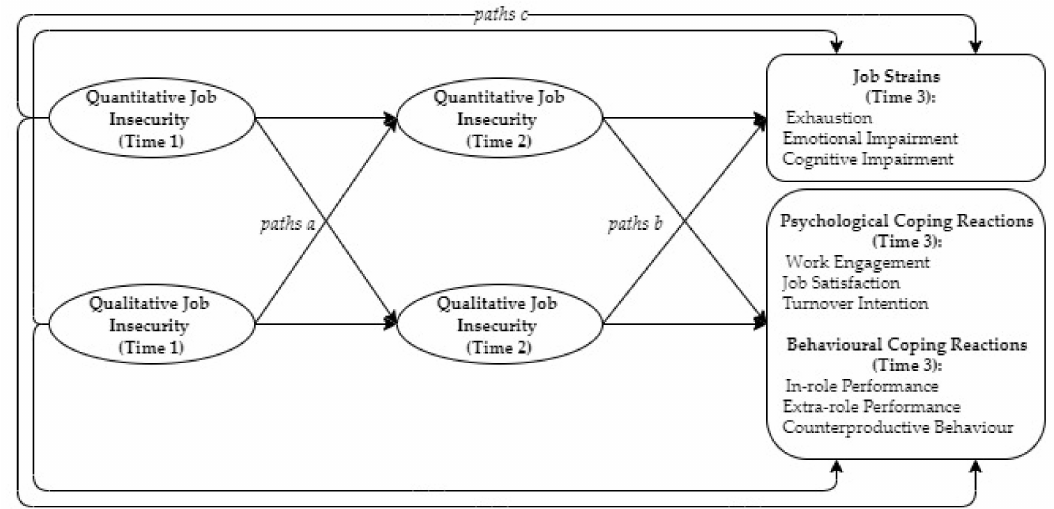
Figure 1. Representation of the theoretical model. Note: Paths a , b , and c represent the causal effects implied by the mediation processes. Indirect effects equal a × b ; total effects equal c + (a × b